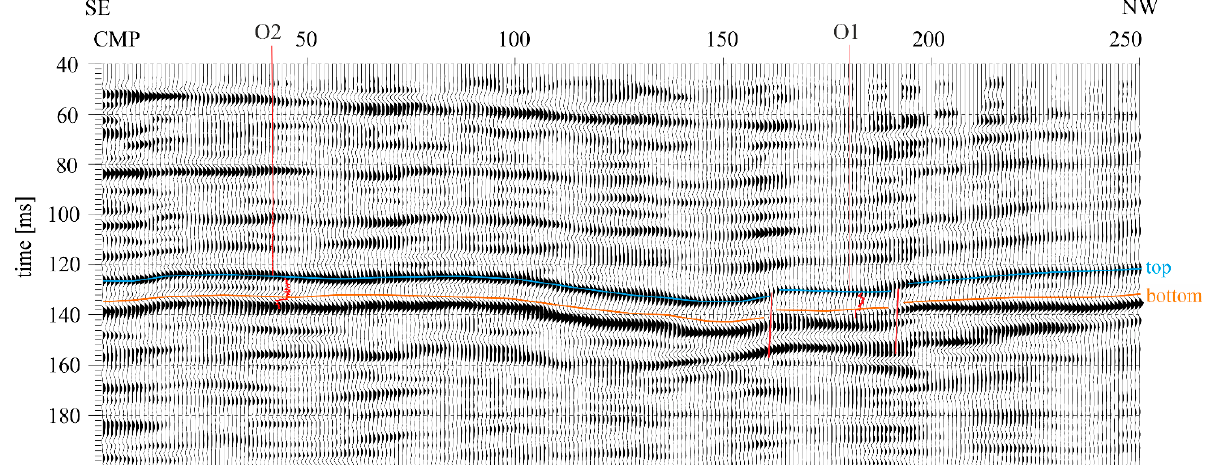
Figure 9. Seismic cross section with interpretation and boreholes with P-wave velocity logs displayed. Blue and orange horizons show top and bottom of the deposit respectfully.